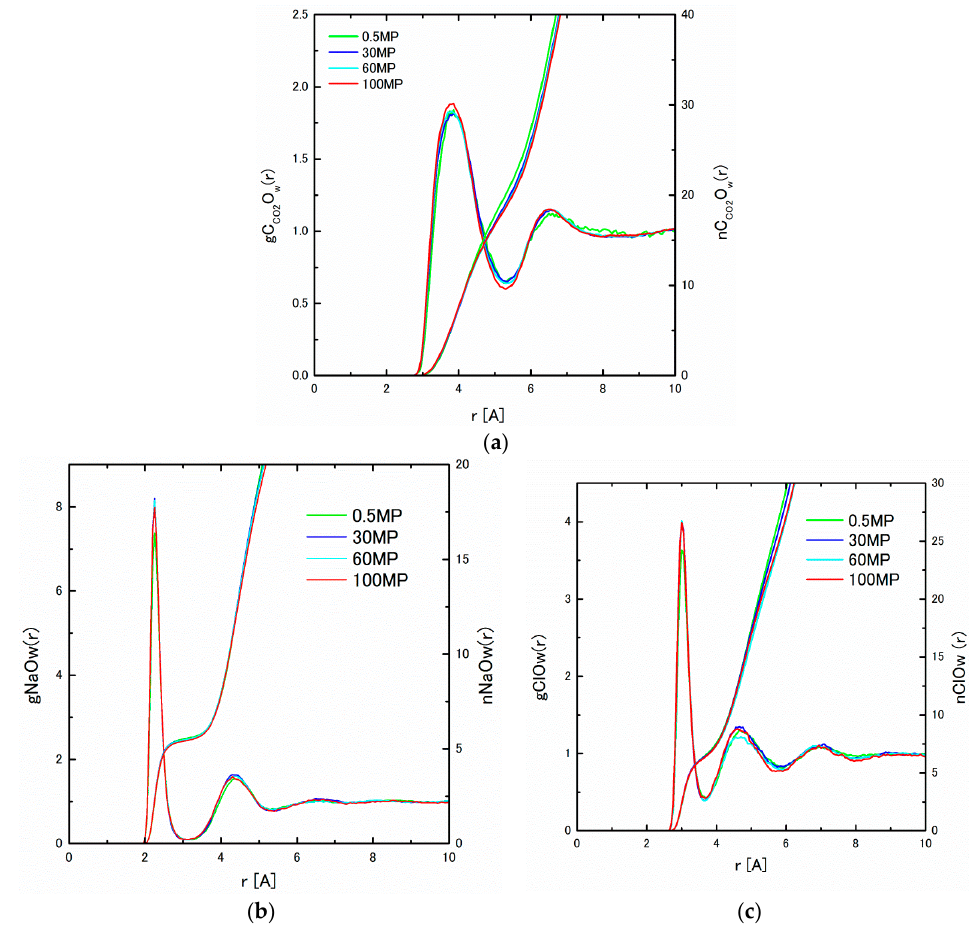
Figure 2. ( a ) gC CO2 O w ( r ) and nC CO2 O w ( r ) under 0.5 (283 K), 30, 60, and 100 MP at 275 K; ( b ) gNaO w ( r ) and nNaO w ( r ); and ( c ) gClO w ( r ) and nClO w ( r ) under 0.5 (283 K), 30, 60, and 100 MP at 275 K.